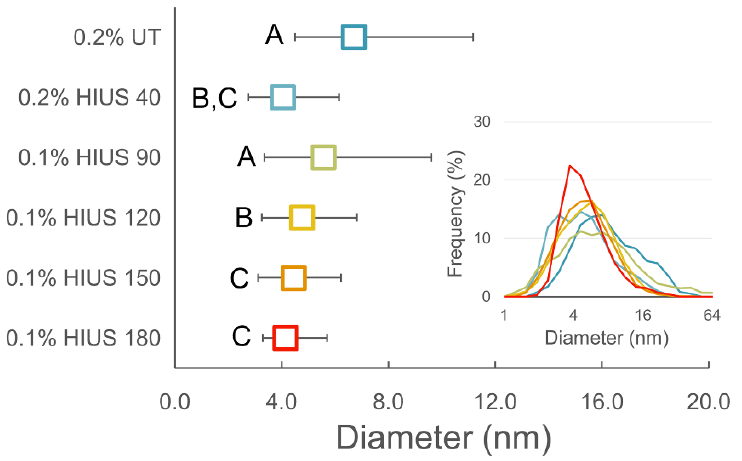
Figure 2. Changes in diameter of cellulose fibers with respect to applied ultrasound treatment. Points on the main plot indicate median values of fiber diameters, while whiskers indicate lower (Q1) and upper quartile (Q3), respectively. Subplot shows distribution of fiber diameters in logarithmic scale; different letters mean the significantly different results at p < 0.05.